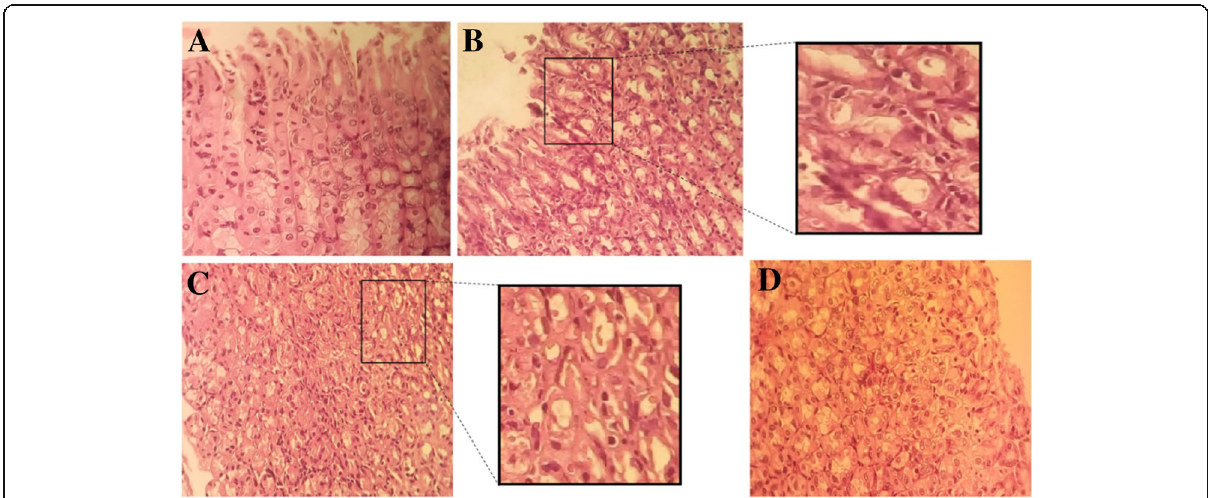
Fig. 3 The gastric mucosa appearance stained with H&E (100x magnified) in ( a ) normal, ( b , C) indomethacin-induced lesions and ( d ) gastric ulcer after treatment with AW extract. Normal sections have intact epithelium with distinct chief and parietal cells where ulcer areas show epithelium damage and infiltration of leukocytes